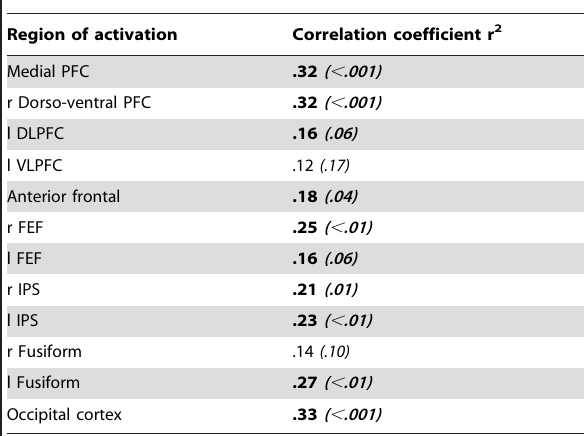
Table 4. Correlation between STM capacity estimates (K) and related beta values in load-sensitive regions. r 2 values are provided with p values in